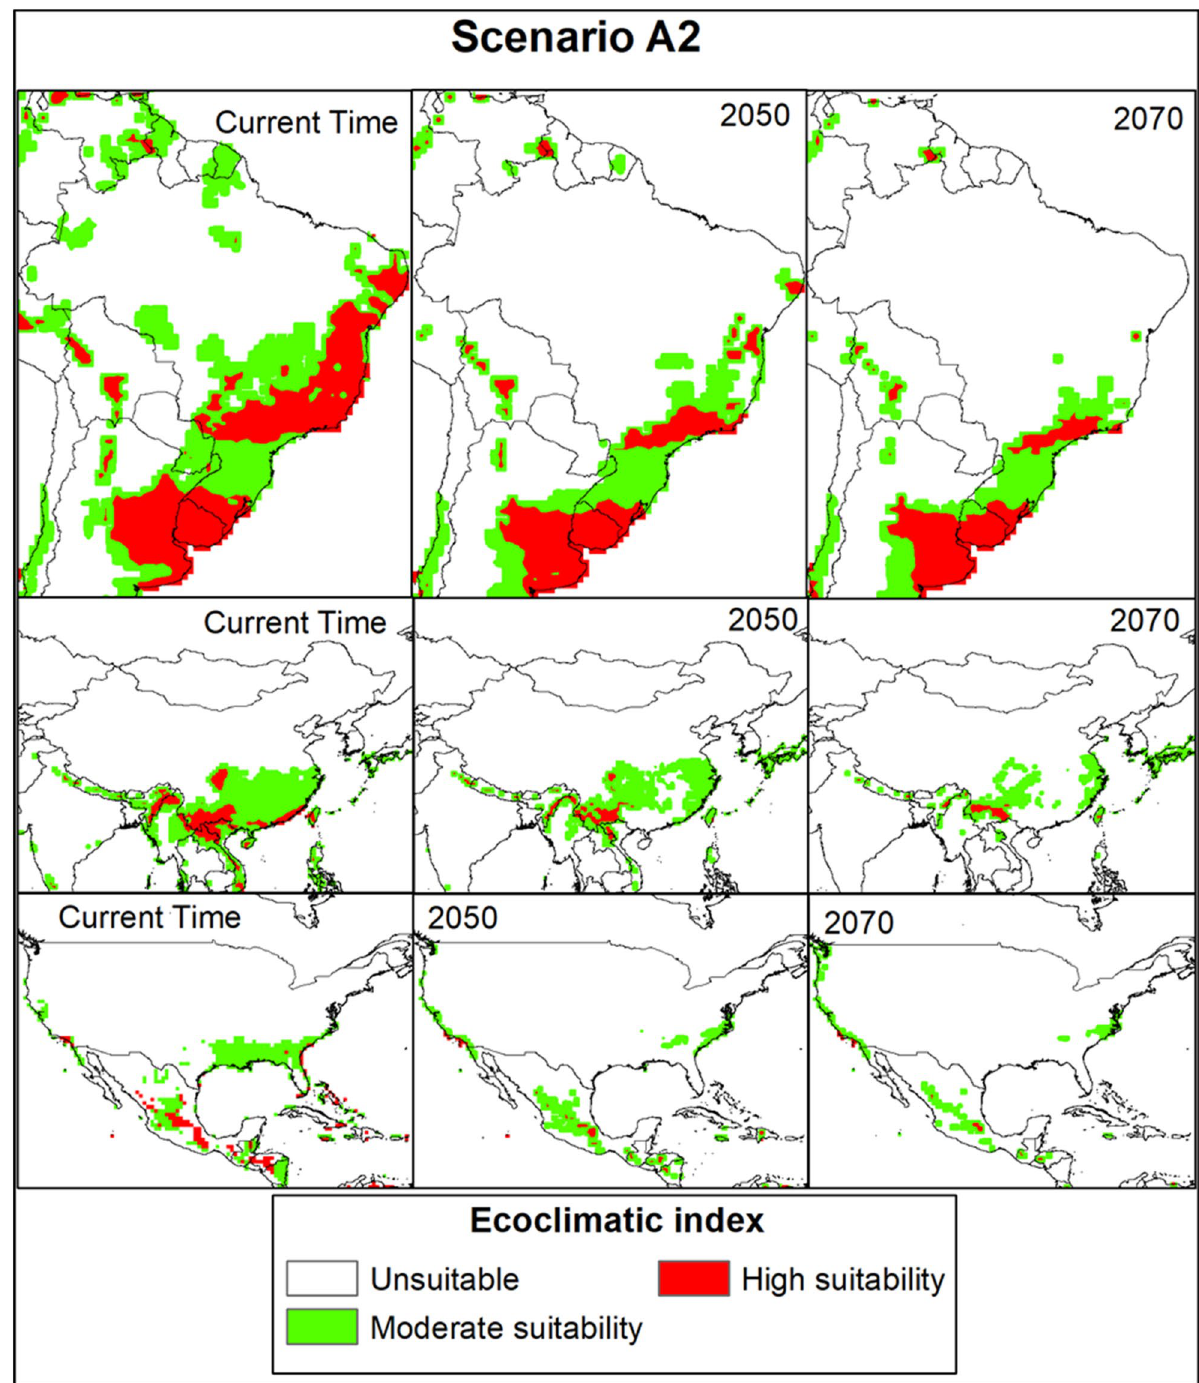
Figure 7. The Ecoclimatic Index (EI) for Trioza erytreae in A2 scenario for the current time, 2050 and 2070, respectively, in Brazil, China, and USA (the largest citrus-producing countries). ESRI ArcMap 10.2.2 (https:// suppo rt. esri. com/ en/ Produ cts/ Deskt op/ arcgis- deskt op/ arcmap/ 10-2- 2# downl oads) and CLIMEX 4.0.0 (https:// www. hearne. softw are/ Softw are/ CLIMEX- DYMEX/ Editi